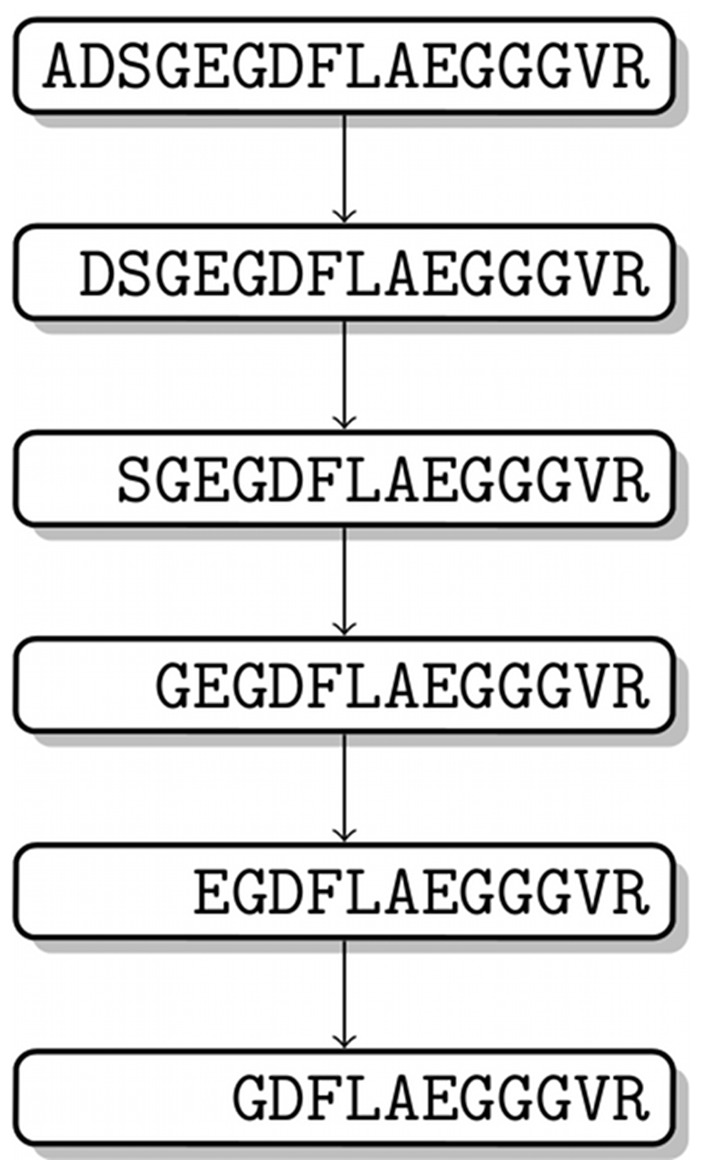
Degradation graph of the degradation of fibrinopeptide A (FPA) as reported in [16].